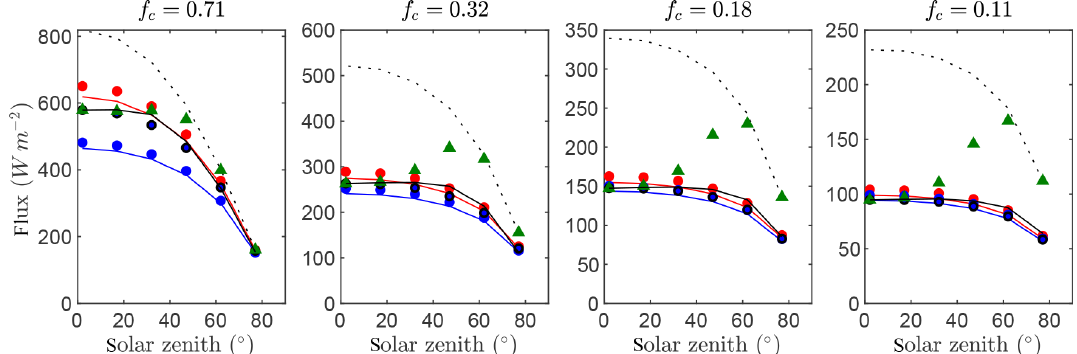
Figure 8. Flux of intercepted radiation versus solar zenith angle for a half-diurnal cycle in a canopy of trees (see Fig. 3e). Varying ground cover fractions f c were simulated as labeled in each pane. The exact flux is given by the output of the 3-D model (black line), which is compared against the 1-D models BINOM (red line), NIL99_B (red circle), and NIL99_P (blue circle) and Ni10_P (blue line), OM_CON (black circle), OM_VAR (green triangle), and HOM (dotted line).